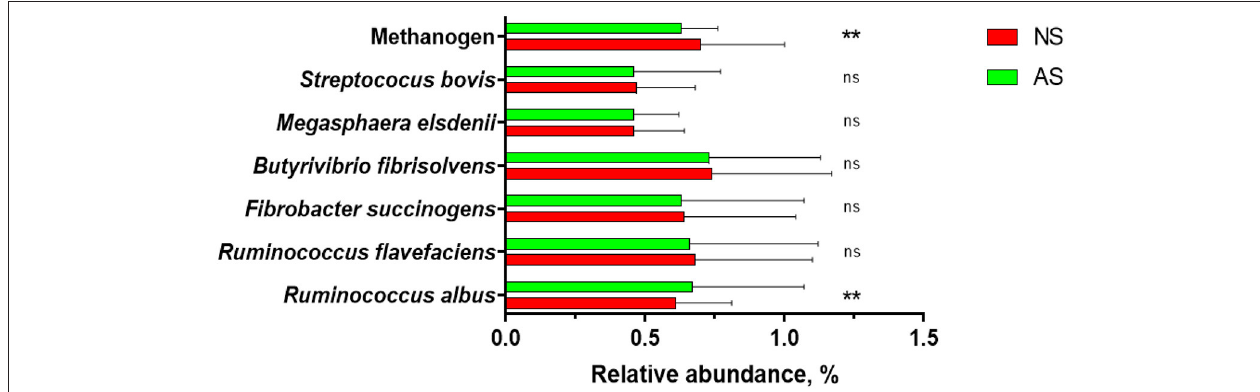
FIGURE 1 | The relative abundances of selected microbial rumen of goats fed a total mixed ration supplemented with Napier grass silage (NS) or anthocyanin-rich black cane silage (AS). Values are means, with their standard errors represented by horizontal bars. Values was different (** P < 0.001); ns P > 0.05).